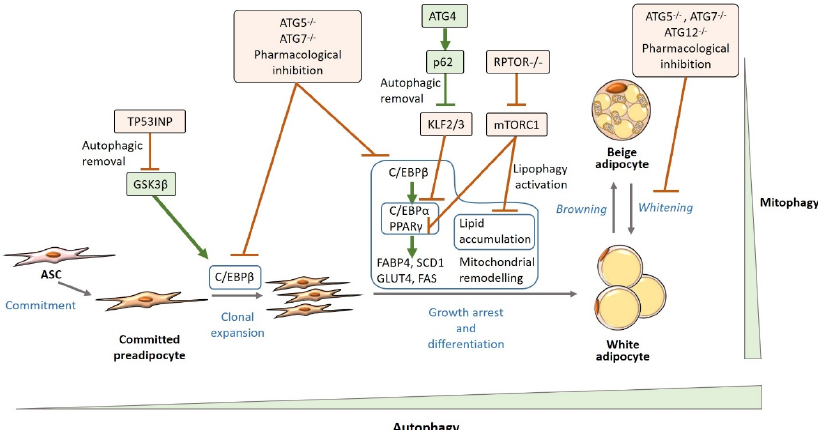
Figure 1. Autophagy modulates white adipogenesis. Autophagy is induced during adipogenesis. Genetic and pharmacological inhibition of autophagy has been shown to repress early and late adipogenesis. Similarly, mitophagy is required for whitening of beige adipocytes. In fact, autophagy inhibition maintains beige phenotype. Despite most of the studies suggest that autophagy promotes adipogenesis and the white adipocyte phenotype, others have found opposite evidence, e.g., autophagic removal of adipogenic activators such as GSK3β or lipophagy activation by mTORC1 inhibition, which results in impaired lipid accumulation in terminal phases of adipogenesis together with PPARγ downregulation. Here we present an overview of the evidence relating autophagy with white adipogenesis. Reddish elements depict negative effects on adipogenesis, while green elements favor white adipocyte formation.